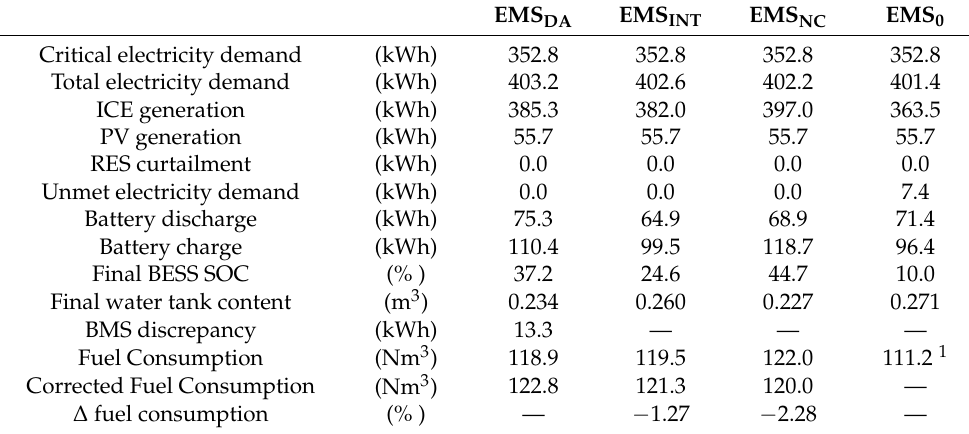
Table 3. Energy summary—day 1 (the microgrid was operated with EMS DA , while the others are simulation results).